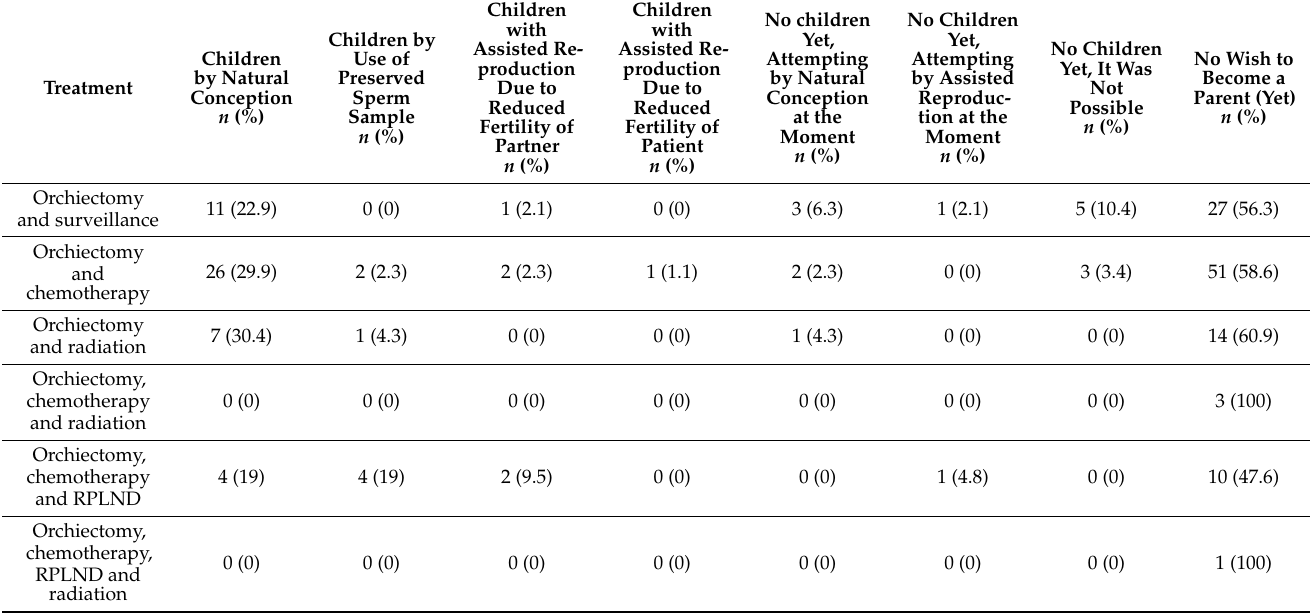
Table 5. Children after testicular cancer with reference to previous